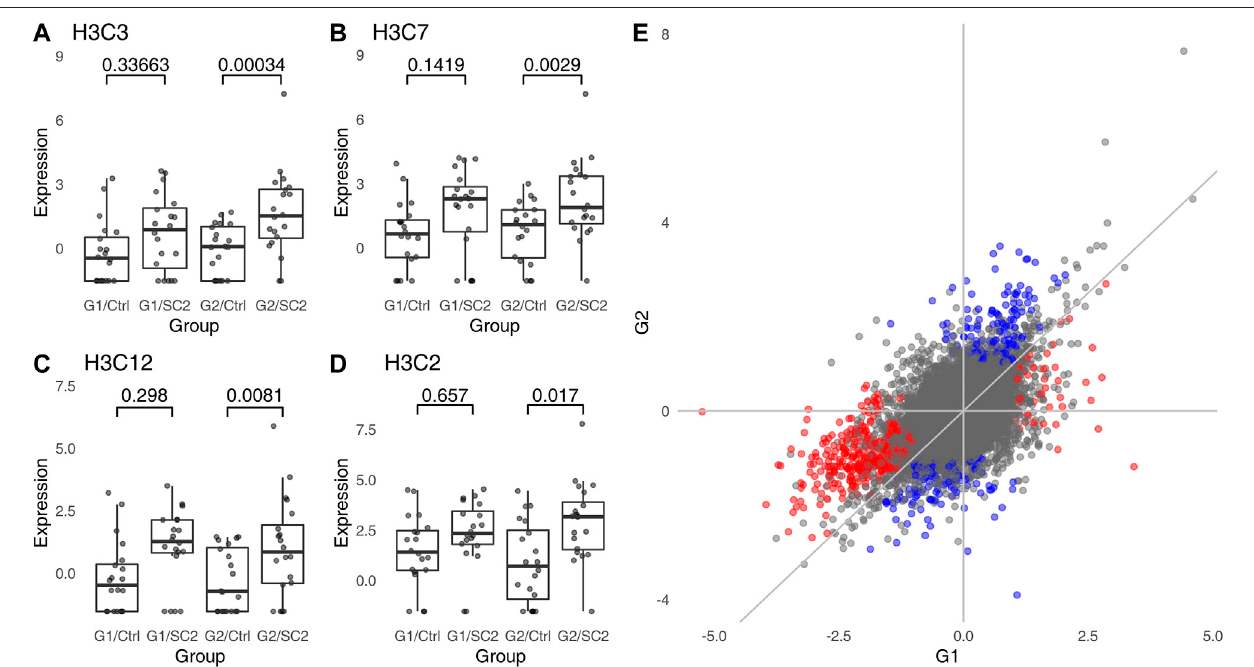
FIGURE2| Geneswhicharesigni fi cantinone comparison, but nottheotherdo notshowastatistically signi fi cantinteraction. (A – D) ,examplesofgeneswhich are DEGinonegroup,butarenotsigni fi cantlydifferentintheothergroup. “ Ctrl, ” healthyindividuals; “ SC2, ” Sars-Cov-2infectedpatients.ValuesabovetheplotindicateFDR ( p -valuescorrected formultiple testing). (E) ,correlationbetween log 2 foldchangesinG1and G2.Color indicates geneswhich aresigni fi cantinone, butnot signi fi cantin the other comparison; red indicates genes signi fi cant in G1, blue indicates genes signi fi cant in G2. The overall Pearson correlation coef fi cient between log 2 fold changes is